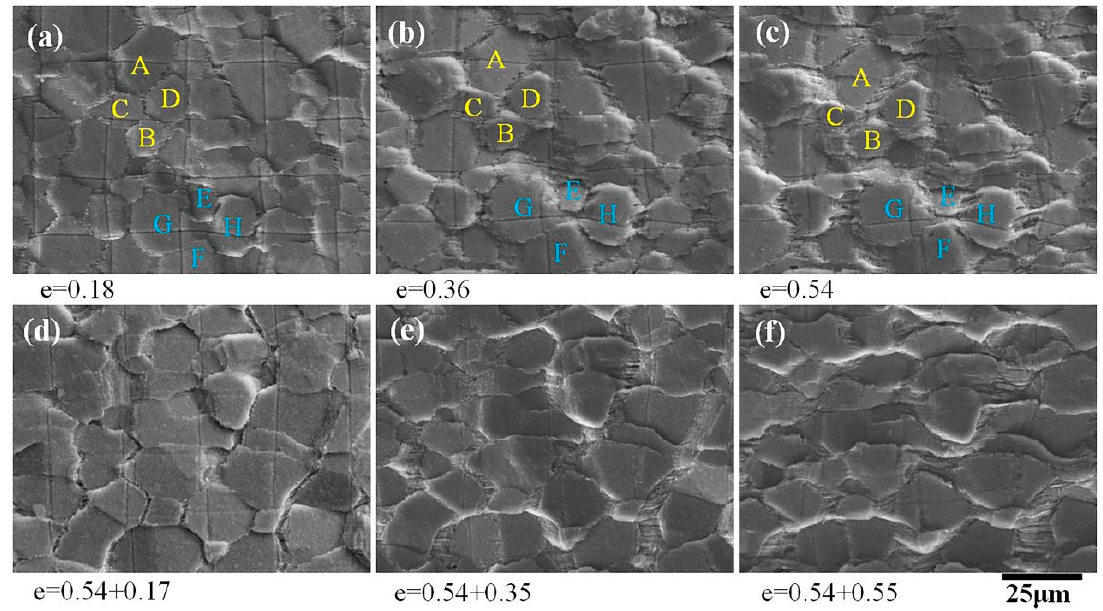
Figure 7. SEM secondary electron images of the local coarse grids after superplastic deformation at 490 °C and 2 × 10 − 4 s − 1 .